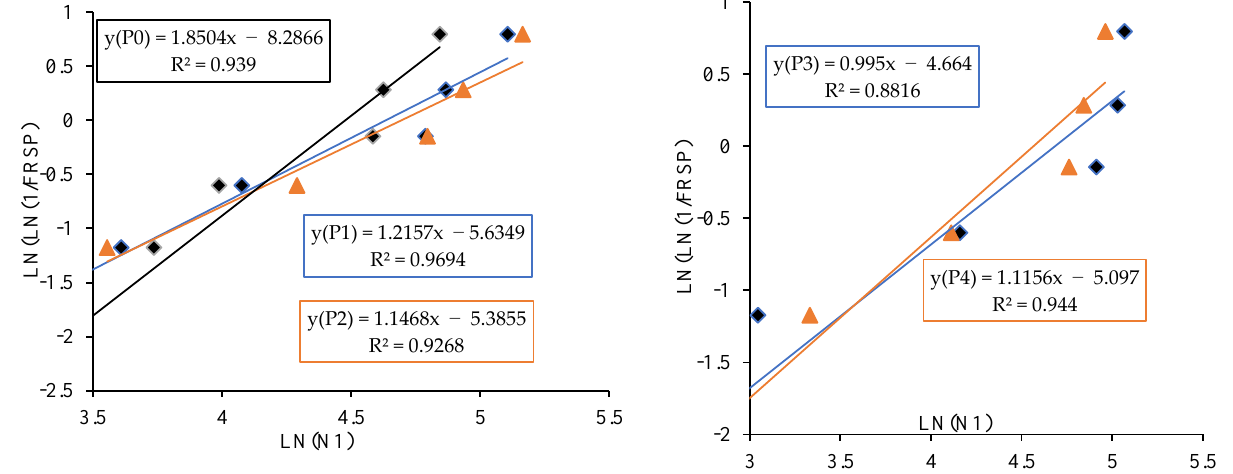
Figure 18. Weibull distribution for P0, P1, P2, P3 and P4 mixes at initial crack on 14 days.